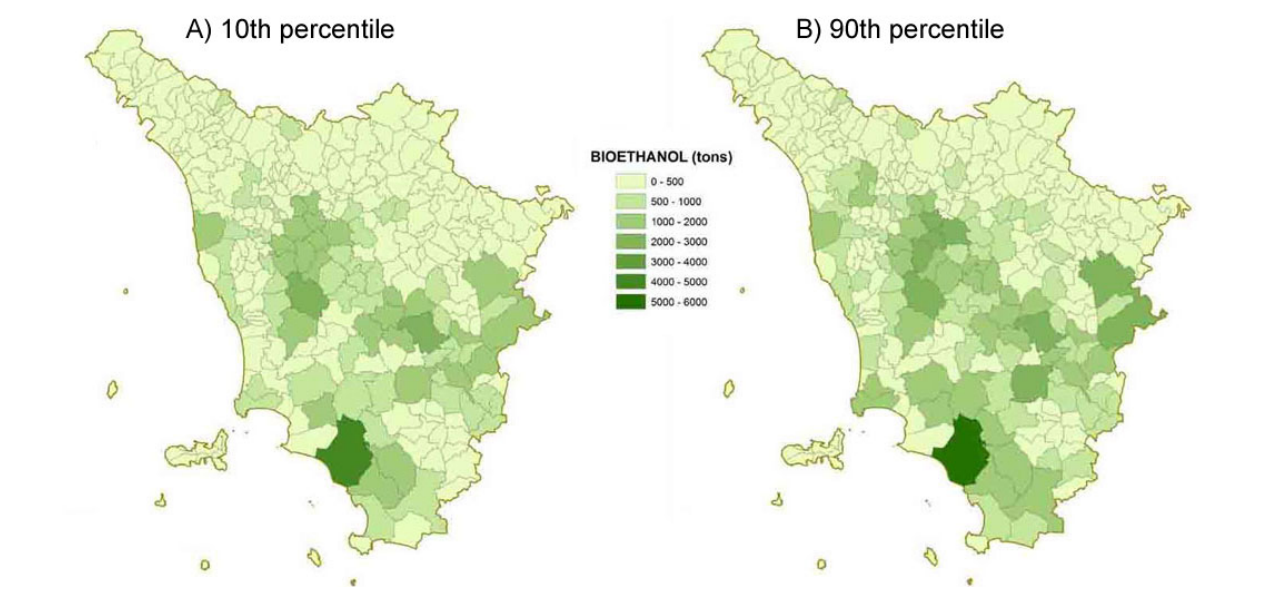
Fig. 1. Maps of 10th and 90th percentile of potential production of bioethanol in the reserved lands of